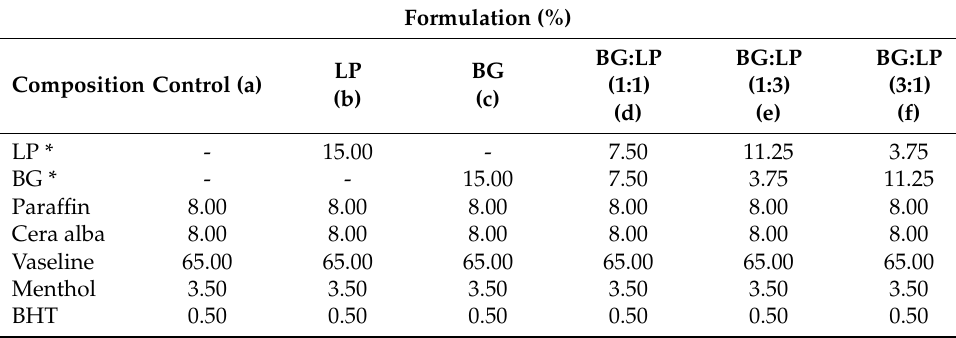
Table 5. Spice stick balsam